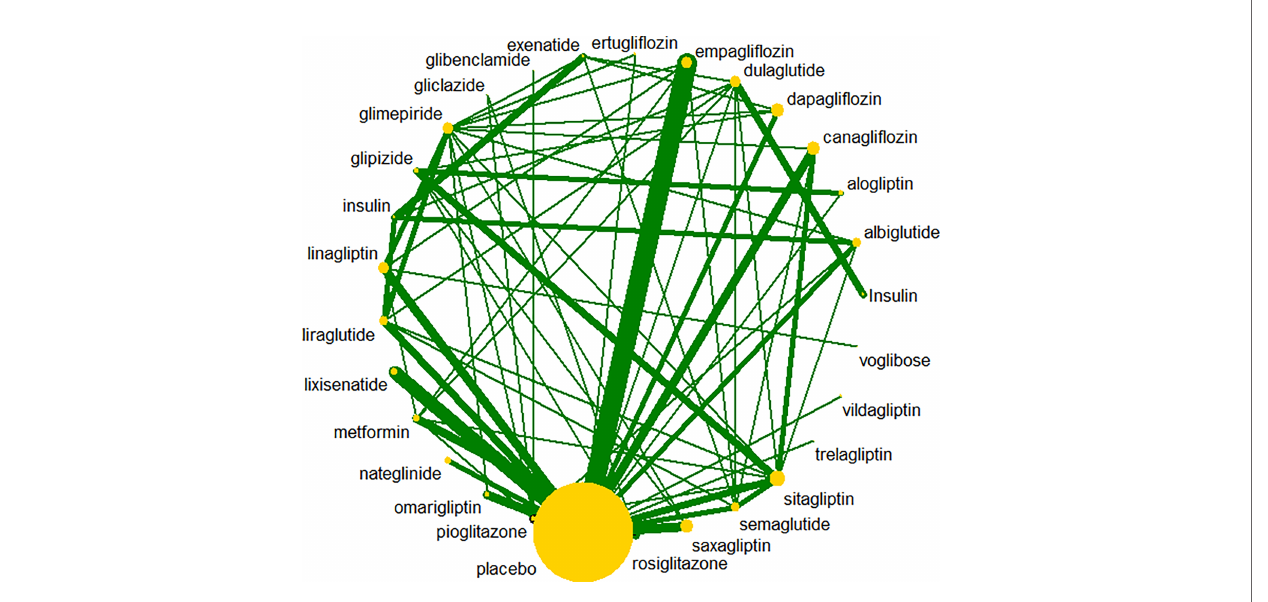
FIGURE 2 | Network plot for the Bayesian network